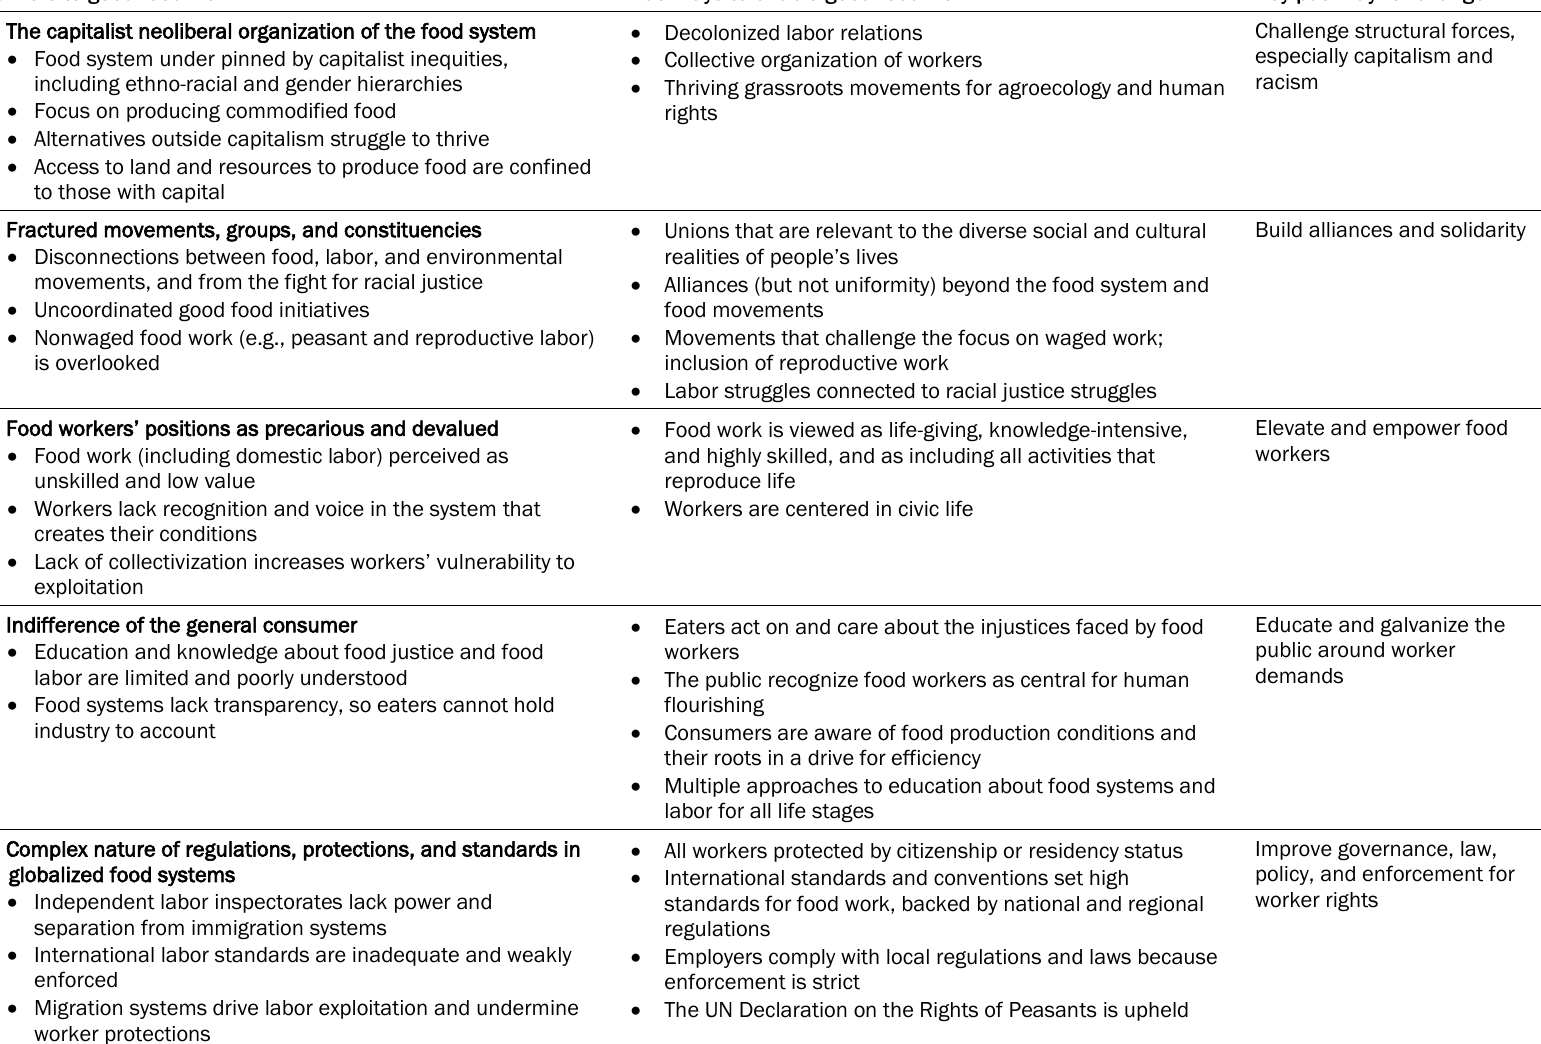
Table 1. Barriers and Pathways to Good Food Work in the Broader Food System Barriers to good food work Pathways to enable good food work Key pathway for